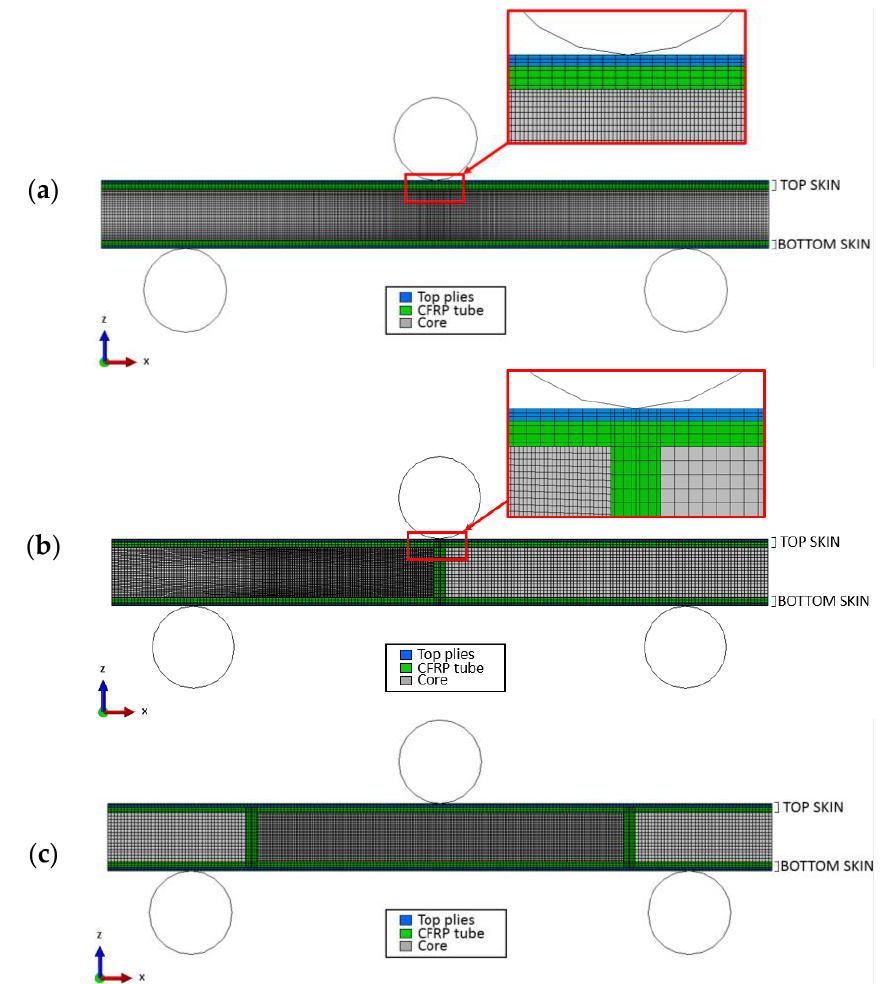
Figure 4. Details of the mesh for the FE model of ( a ) ‘Configuration 1′ ( b ) ‘Configuration 2′ and ( c ) ‘Configuration 3′ specimens.